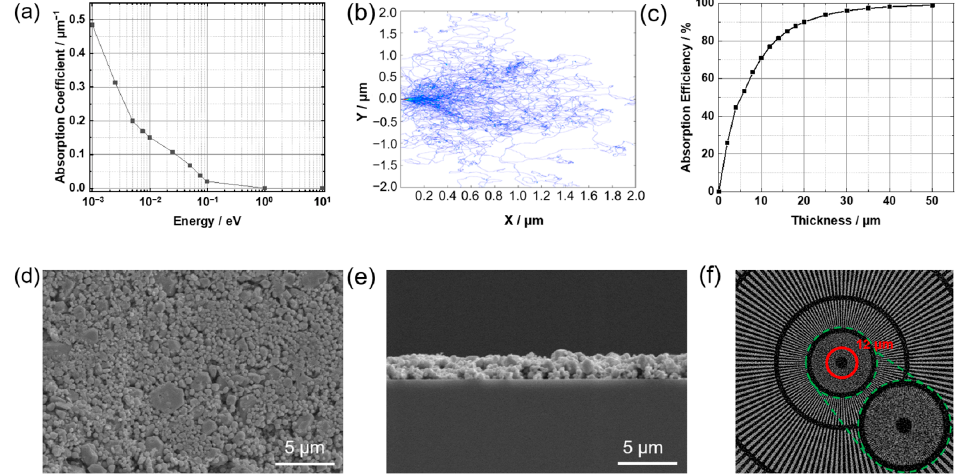
Figure 6. ( a ) Absorption coefficient of the GOS:Tb scintillation screen under different energy neutrons. ( b ) The track of the internal conversion electron (Energy: 38.68 keV) in the scintillation screen. ( c ) The neutron absorption efficiency of scintillation screens of different thicknesses. SEM photographs of the GOS:Tb, F scintillation screen prepared with PVB, ( d ) surface morphology, ( e ) cross-sectional view. ( f ) Results of resolution tests using gadolinium Siemens